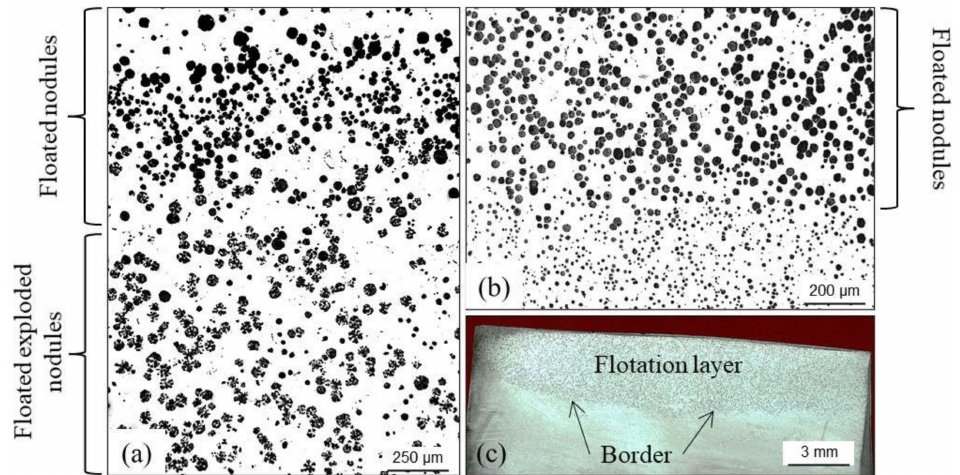
Figure 79. ( a ) Flotation layer containing primary graphite nodules over exploded ones. ( b ) Flotation layer composed of large primary nodules over a normal distribution of nodules. ( c ) Macroscopic view of a flotation layer and transition border.